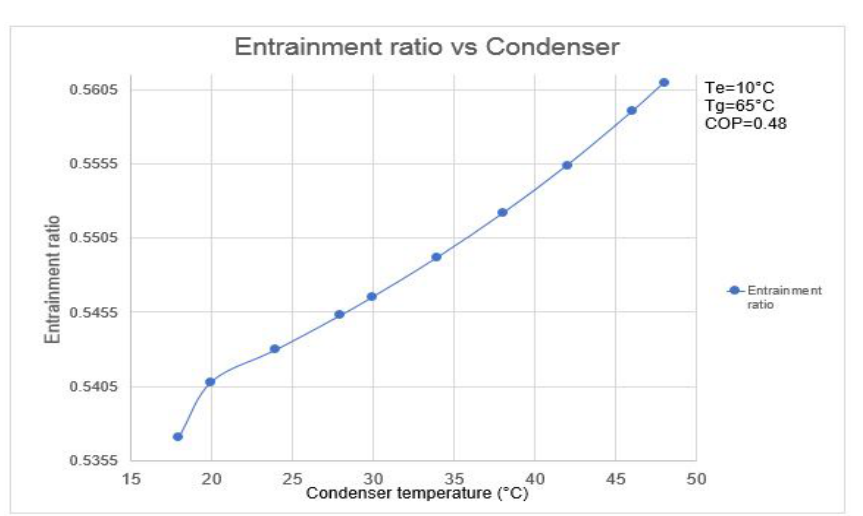
Figure 7. Entrainment ratio with respect to the temperature of condenser.